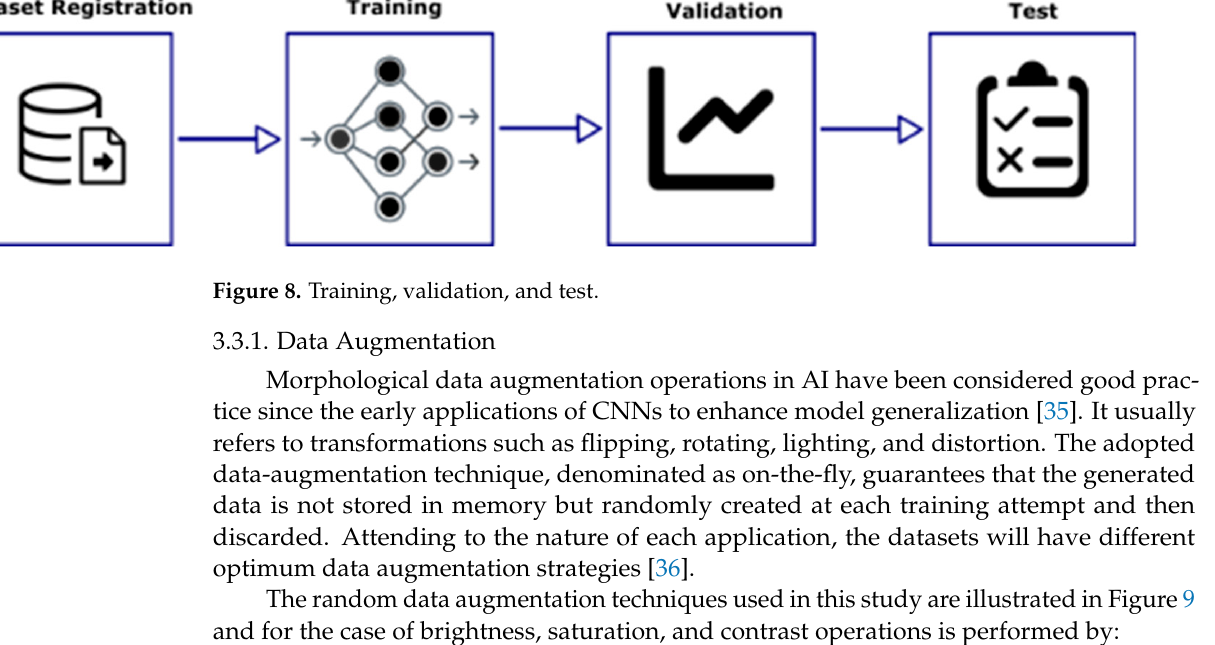
Figure 8. Training, validation, and test.